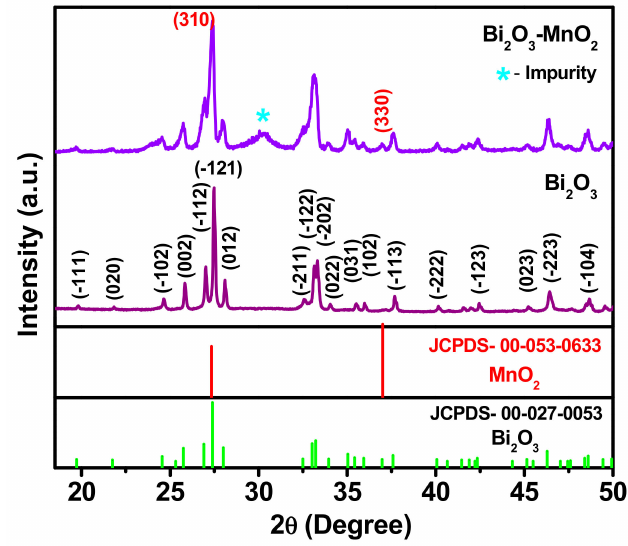
Figure 1. The X-ray di ff raction (XRD) patterns of Bi 2 O 3 and Bi 2 O 3 -MnO 2